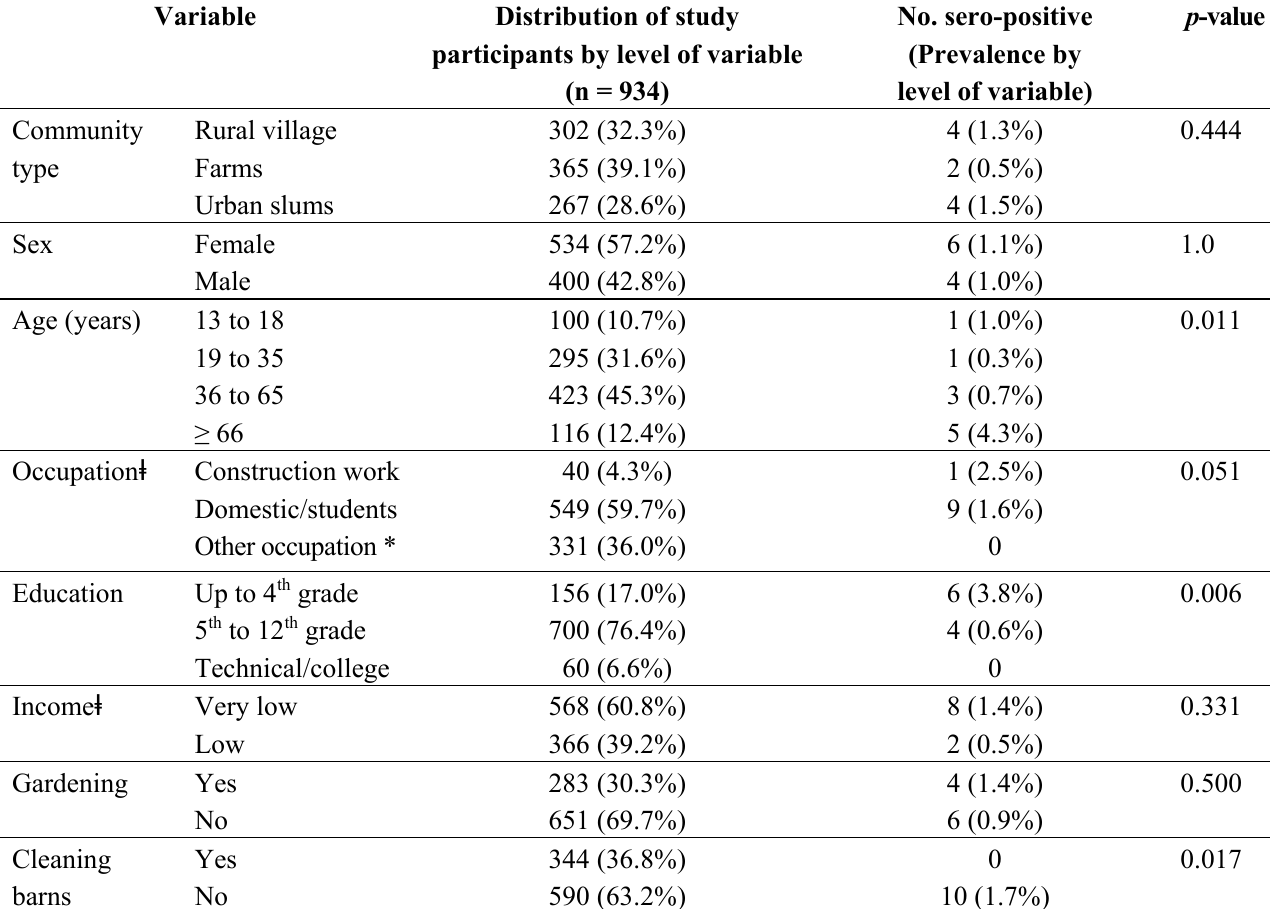
Table 1. Description of study population and group-specific seroprevalences of hantavirus in Los Rios, Chile 2010-2012.